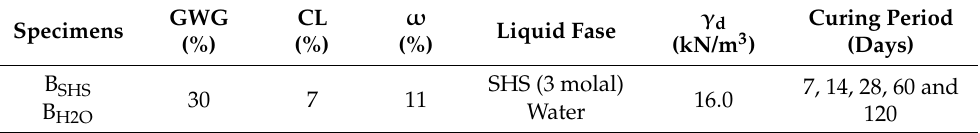
Table 3. Mix proportion of the laboratory